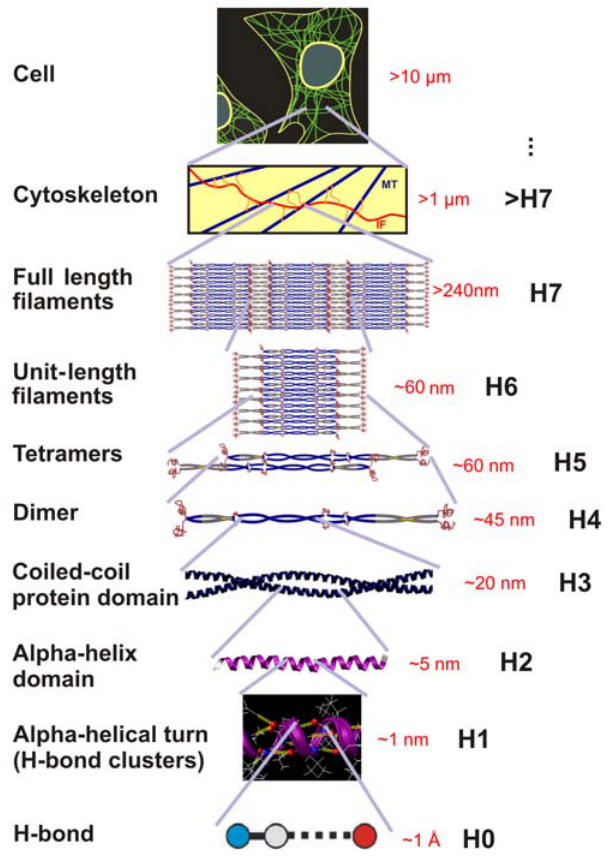
Figure 1. The hierarchical structure of intermediate filaments, from atomic to cellular scales. The figure shows relevant structural levels H0–H7. See Table 1 for deformation mechanisms associated with each hierarchical